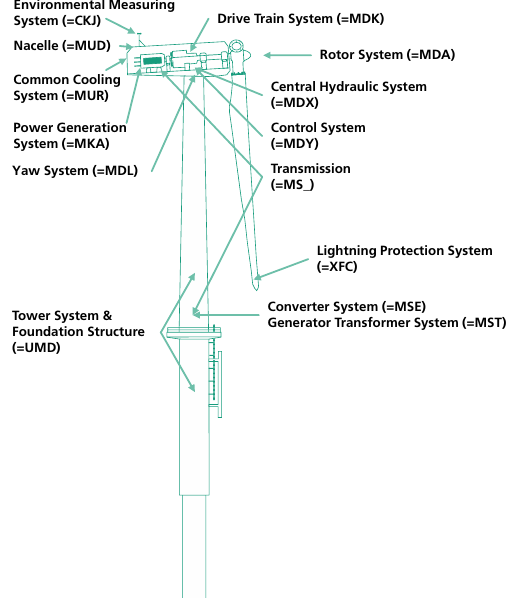
Figure 5. System structure of a WT according to the Reference Designation System for Power Plants (RDS-PP R (cid:13) ) published by VGB PowerTech [66]. The figure does not provide a complete overview on the system structure but highlights the most important systems considered in this